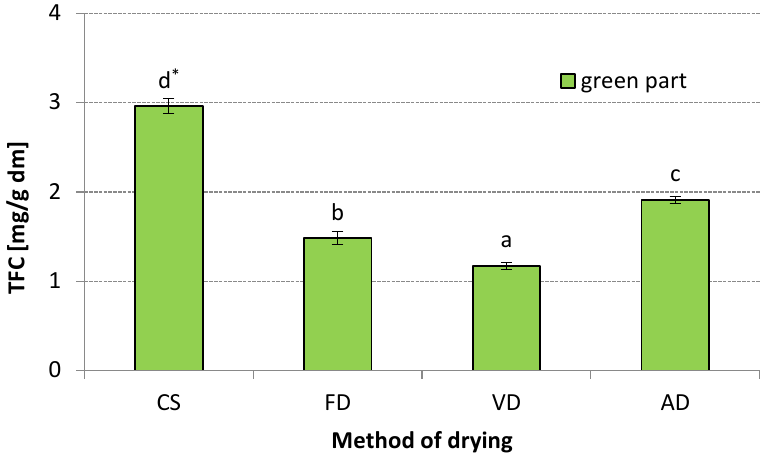
Figure 3. Total flavonoid content (mg/g dm): CS—control sample, FD—freeze-drying, VD—vacuum drying, AD—air drying * The values designated by the different small letters are